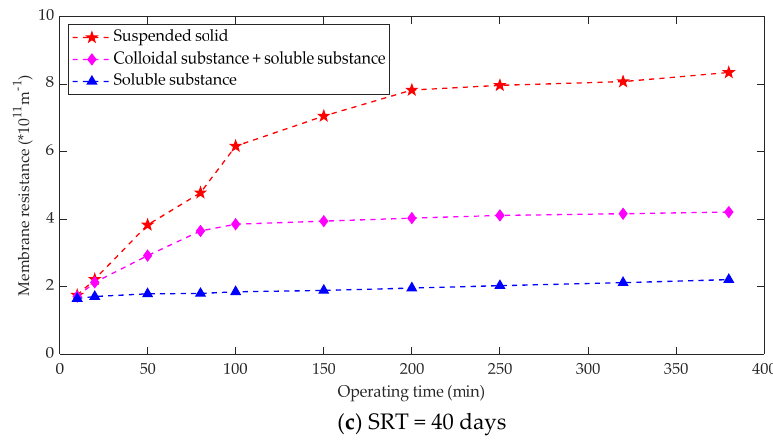
Figure 6. Relation between sludge composition and membrane fouling. ( a ) SRT = 10 days; Figure6. Relationbetweensludgecompositionandmembranefouling. ( a )SRT = 10days;( b ) SRT = 20 days; ( b ) SRT = 20 days; ( c ) SRT = 40 days. ( c ) SRT = 40